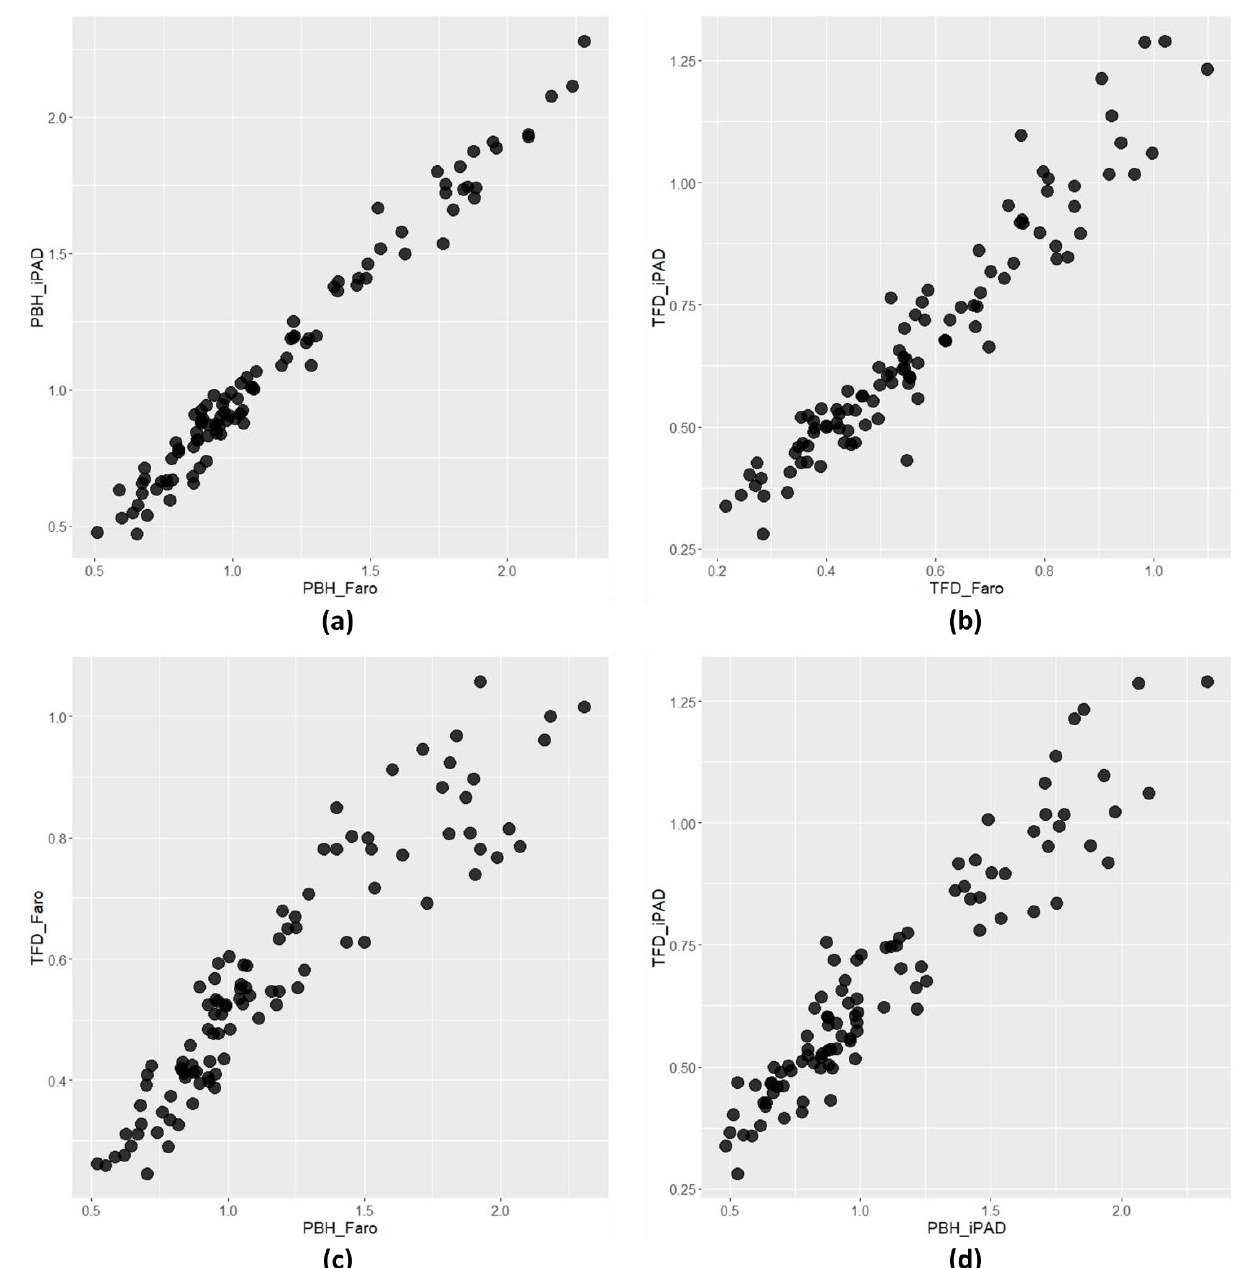
Figure 7. Data dispersal between pairs of variables and their linear pattern: ( a ) PBH; ( b ) TFD data; and ( c ) variables used for the modeling process from TLS FARO; ( d ) from iPad Pro.